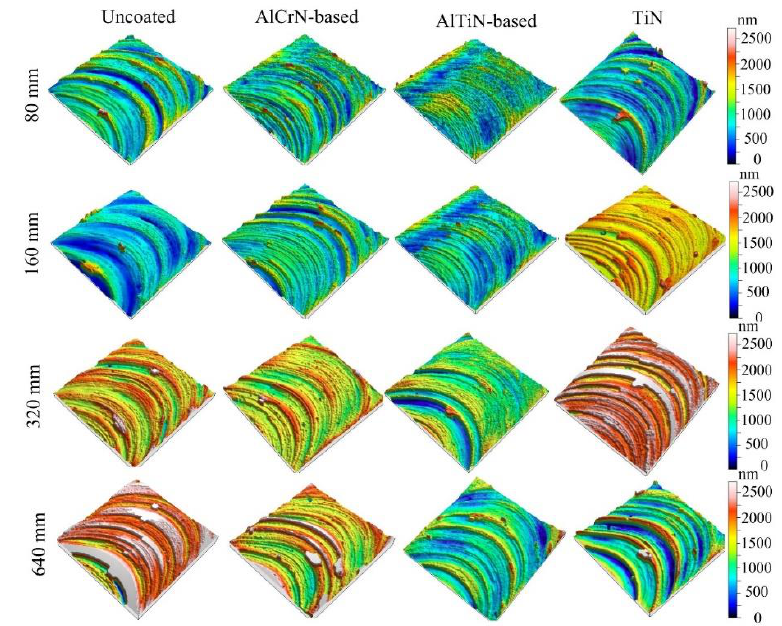
Figure 8. Surface morphologies of microgroove bottoms machined with coated micro end mills.